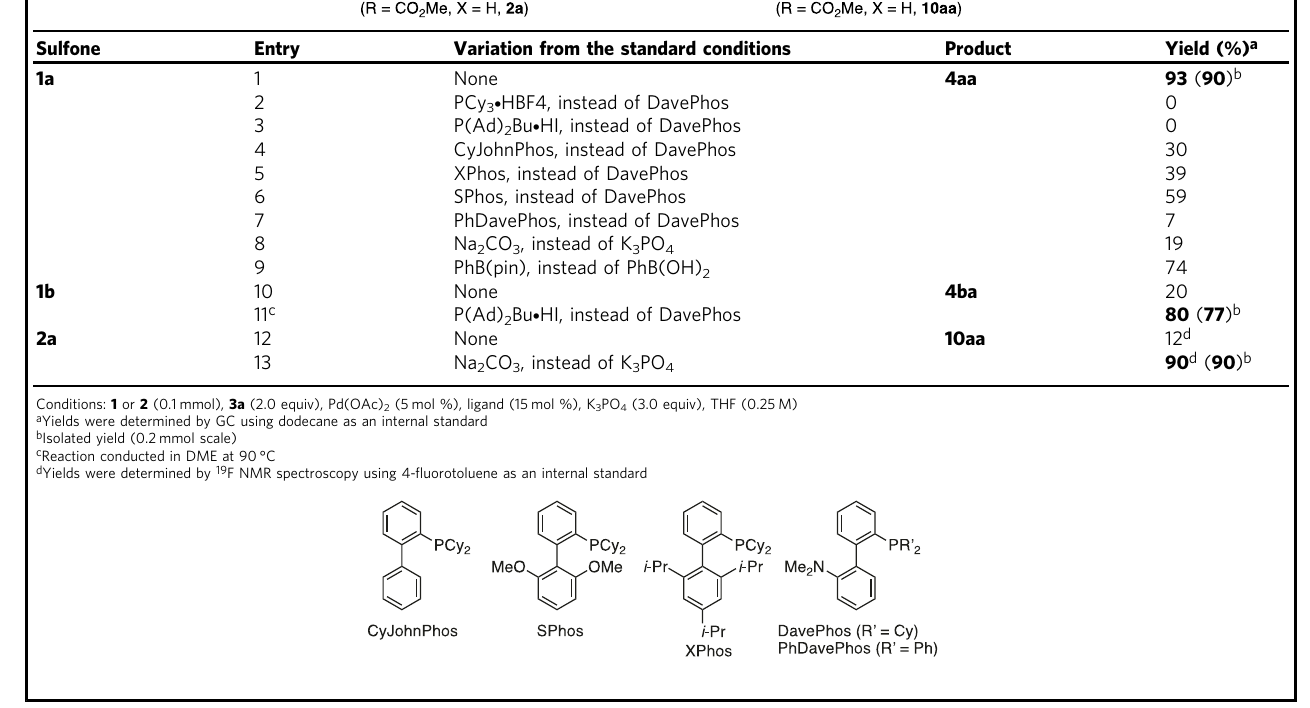
Sulfone Entry Variation from the standard conditions